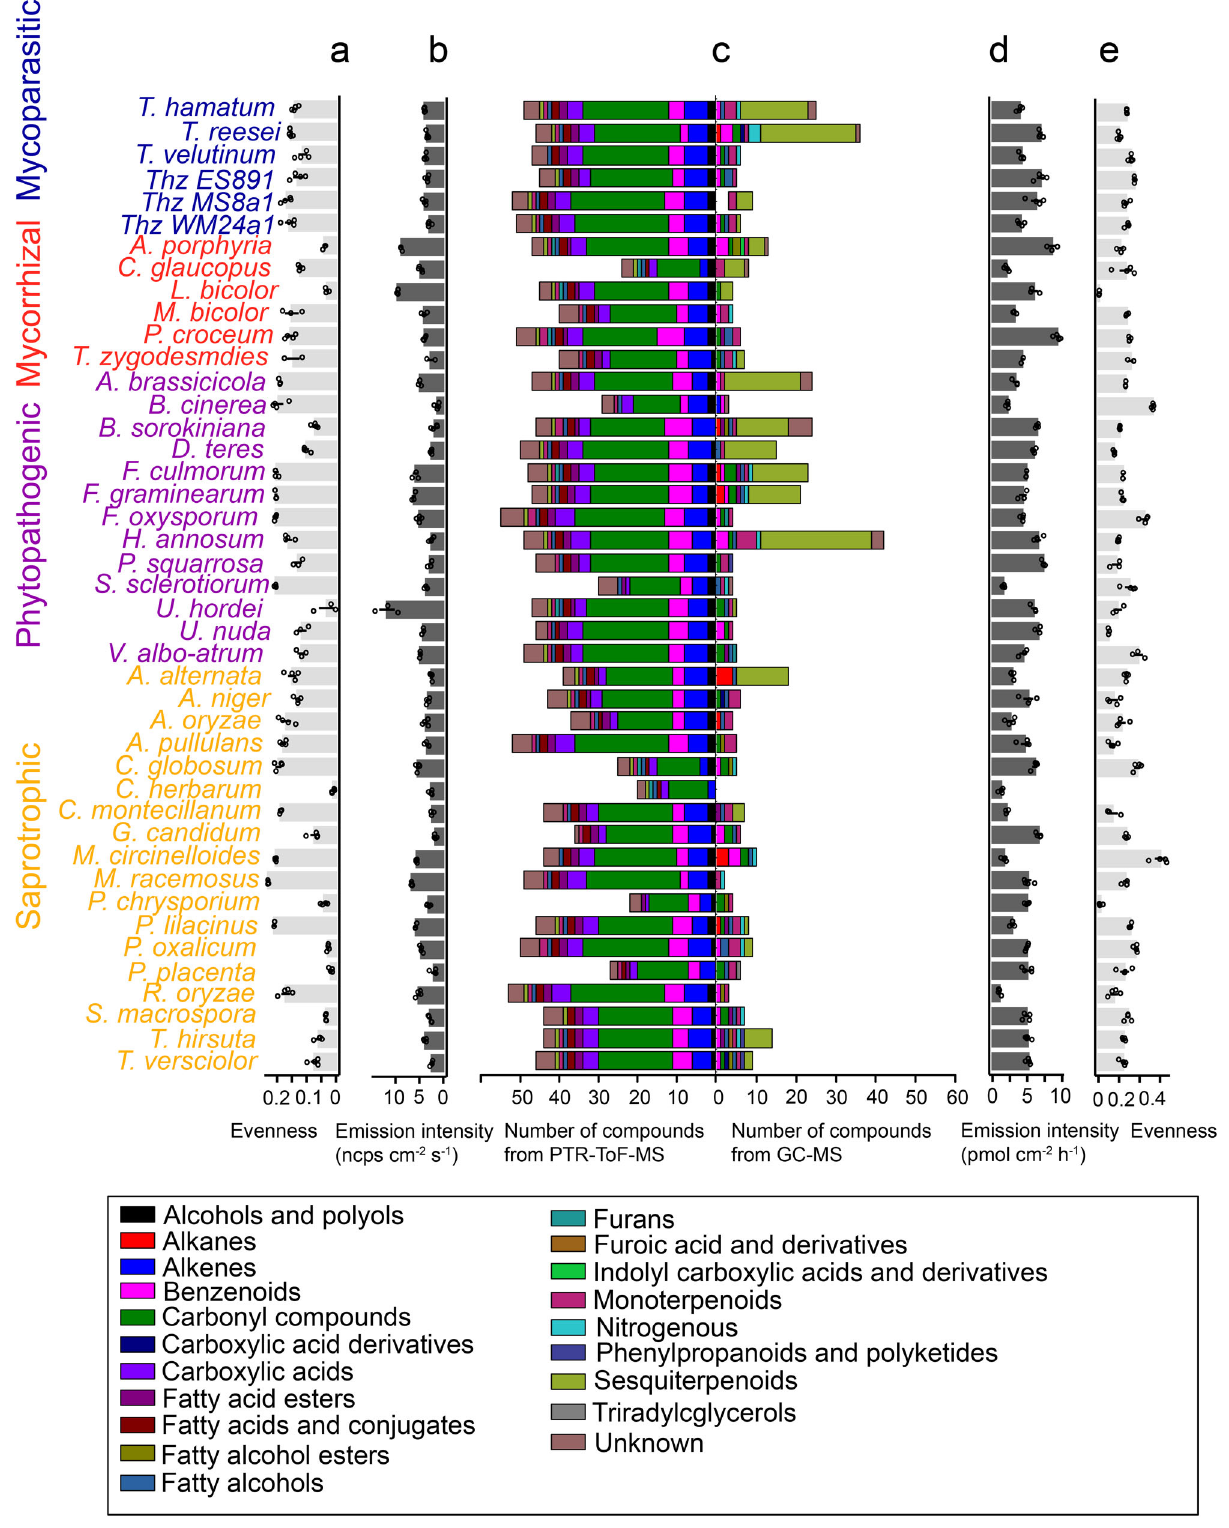
Fig. 2 Chemical diversity of fungal volatile organic compounds (fVOCs) detected from the examined 43 fungal species. a , e The Pilou evenness of species-speci fi c fVOC pro fi les based on PTR-ToF-MS and GC – MS data, respectively. b , d The total emission rates (ncps cm − 2 s − 1 and pmol cm − 2 h − 1 ) based on PTR-ToF-MS and GC – MS data, respectively and c show the number of compounds detected by PTR-ToF-MS and GC – MS. Colors indicate the grouping of fVOCs to structural classes. Thz T. harzianum . Data are shown as means ± SE ( n = 3 biologically independent samples).